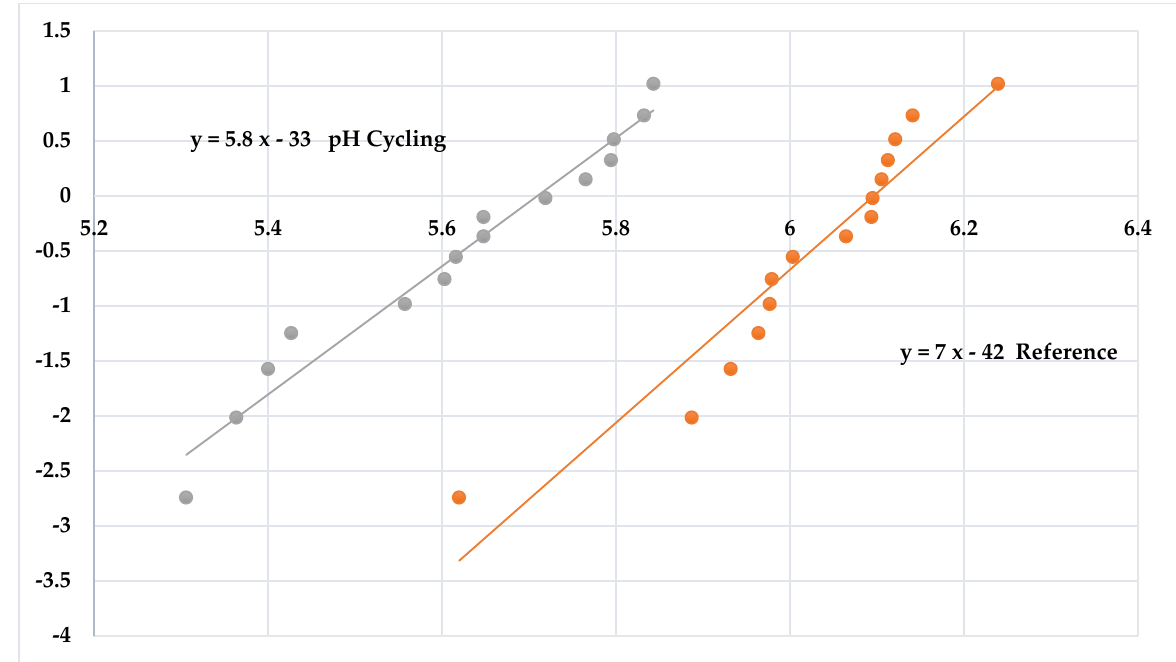
Figure 2. Weibull distribution showing pH 2 with a greater strength distribution.